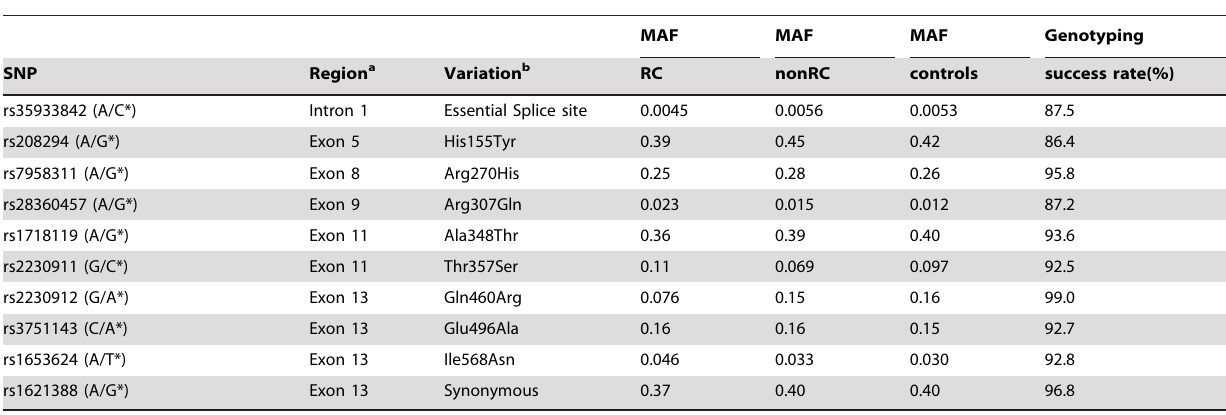
Table 2. SNPs analyzed in P2RX7